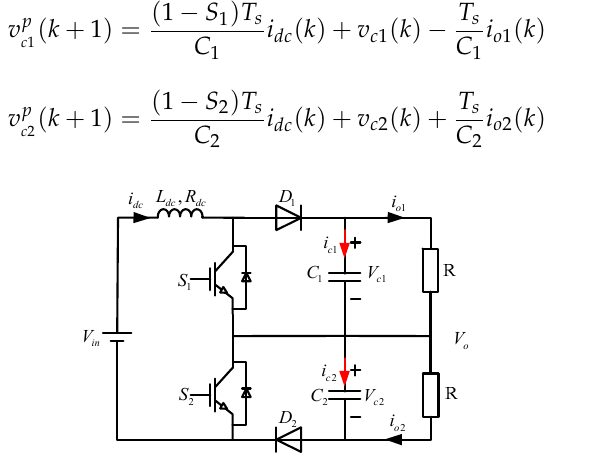
Figure 6. The main boost-TL circuit.